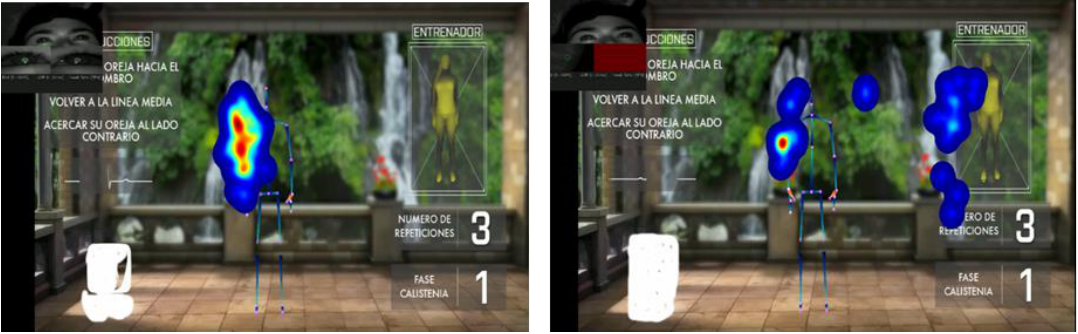
Figure 5. Gazepoint Analysis, eye tracker recording user game vision.